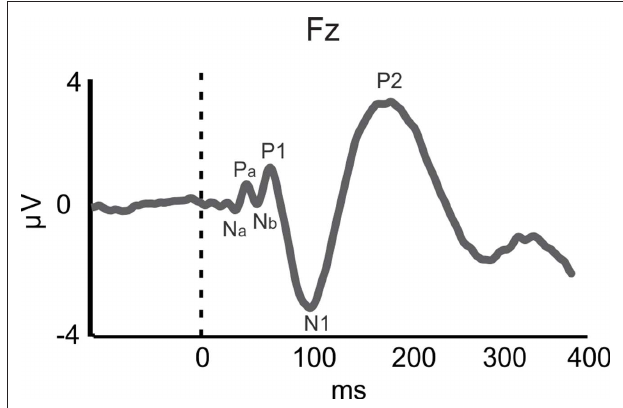
FiGurE 1 | Auditory-evoked potentials (AEPs). AEP waveform for piano tone at the frontal channel Fz for 34 participants (averaged over musicians and non-musicians). The Na–Pa–Nb–P1 complex represents the middle latency response (MLR) originating in primary auditory cortex (A1). The N1 and P2 components represent activity originating in the surrounding belt areas of A1. Based on data from Shahin et